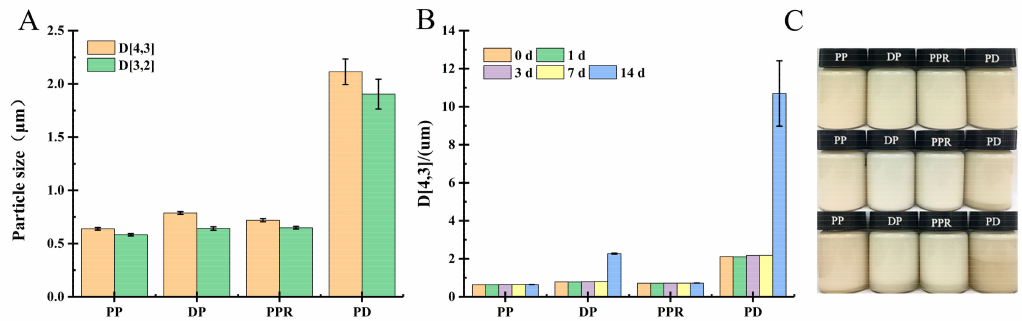
Figure 5. Di ff erent particle size of pomegranate peel pectin PP fresh emulsion ( A ), 14 days of storage under 60 ◦ C ( B ), and the appearance of emulsion in storage environment ( C : 60 ◦ C storage from top to bottom zero days, seven days, 14